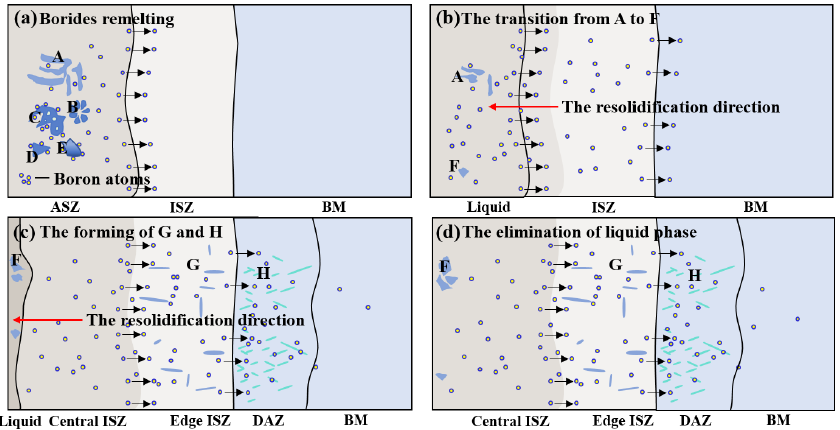
Figure 11. The schematic illustration of the microstructure evolution of the brazing joints during PBHT (A, B, C, D, E, F, G, H represent Area-A-B-C-D-E-F-G, and -H, respectively): ( a ) Borides remelting ( b ) The transition from A to F ( c ) The forming of G and H ( d ) The elimination of liquid phase.